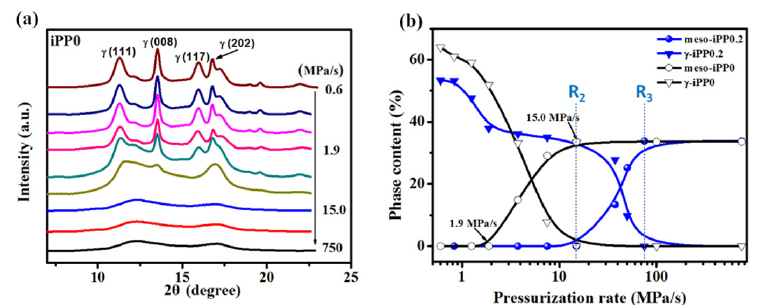
Figure 6. ( a ) Selected 1D WAXD profiles of iPP0 samples solidified by pressuring to 1.7 GPa at different pressurization rates; ( b ) Contents of β phase and γ phase as a function of pressurization rate.